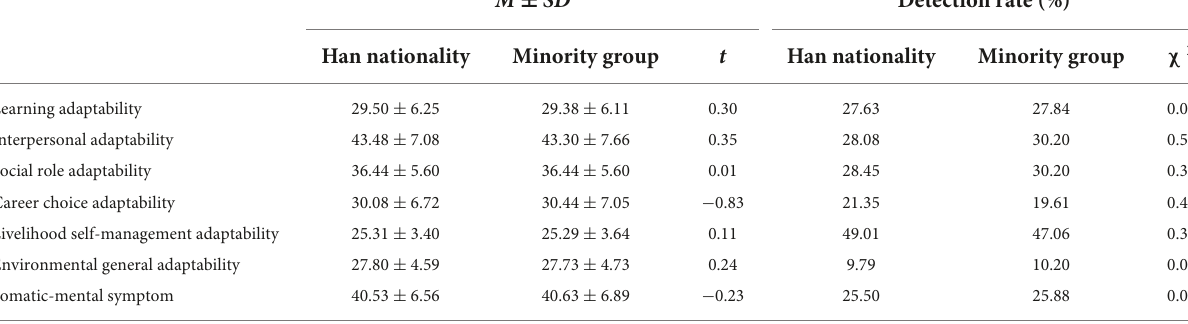
TABLE 6 The differences between left-behind and non-left-behind undergraduates on primary study